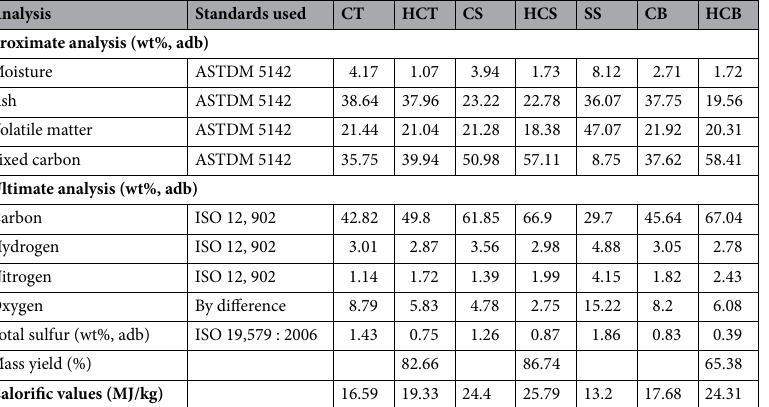
Table 7. Physicochemical properties of produced hydrochar. CT coal tailing, CS coal slurry, HCT hydrochar coal tailing, HCS hydrochar coal slurry, SS sewage sludge, CB blend CT + CS + SS, HCB hydrochar from the blend CT + CS + SS, Solid/liquid ratio:1/4, adb : air dried basis. Oxygen% = 100- (Moiture + Ash + Total Carbon + Hydrogen + Nitrogen + Sulphur).